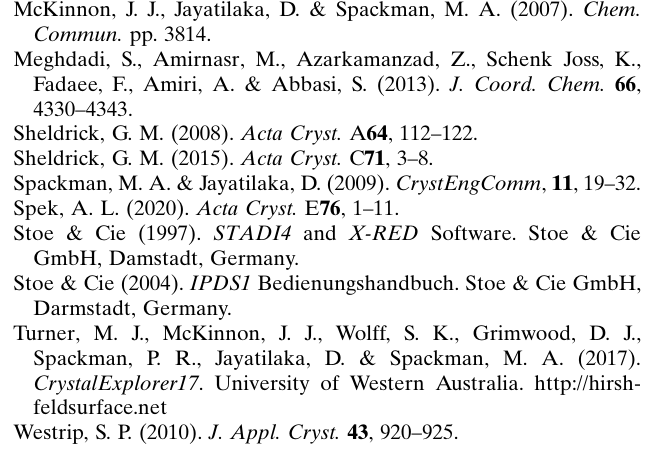
Table 5 Experimental details. Crystal data Chemical